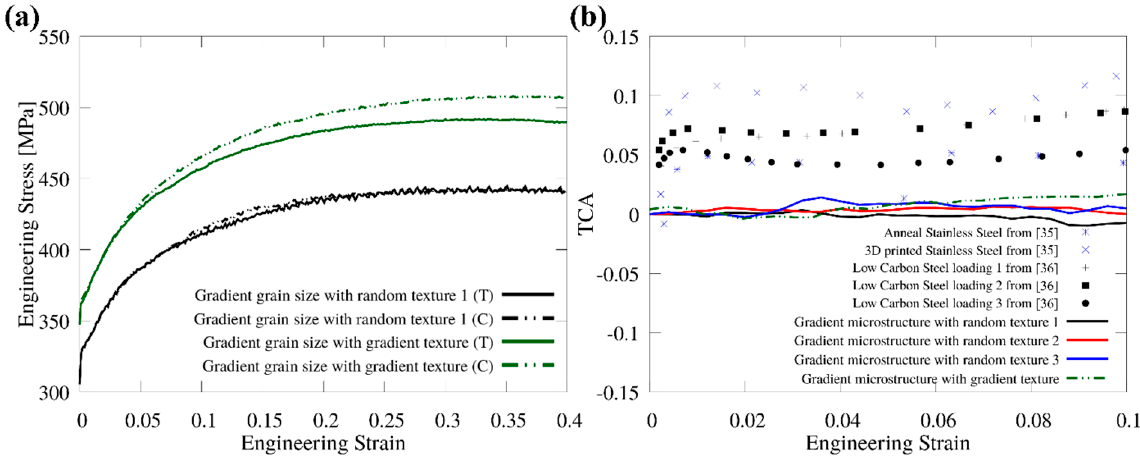
Figure 11. ( a ) Stress-strain curve of gradient grain size with random texture and gradient texture ( b ) TCA in flow stress vs. engineering strain and comparison with experimental data. Solid lines are simulation results; Dot plots in ( b ) are generated using experimental data from [35,36]. Blue dots are from tension/compression tests of 3D-printed stainless steel with and without heat treatment [35]; black data are experimental results of tension and compression tests by varying loading directions [36], 1-RD, 2–45°, 3-TR.